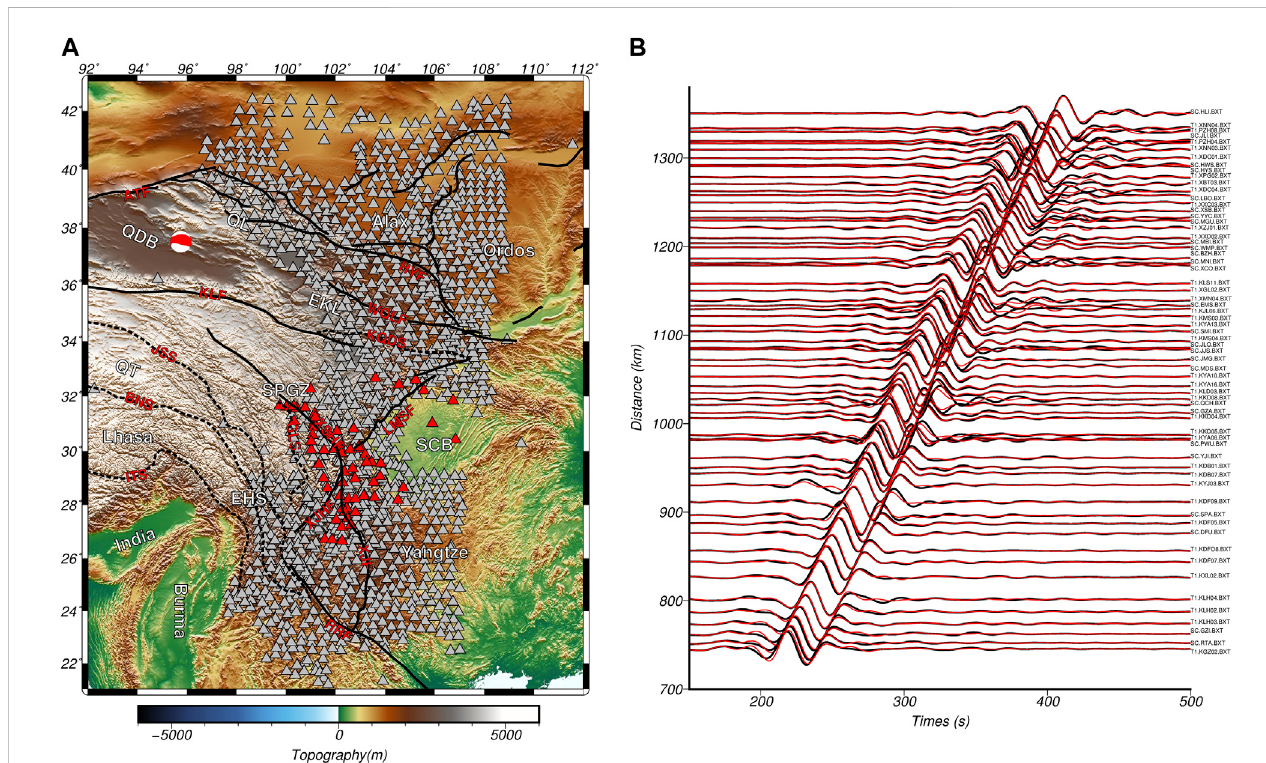
FIGURE 1 Topography, major tectonics, and seismic observations of theeasternTibetan Plateau. (A) Black solid and dashed lines represent faults and suture zones obtained fromtheHimaTibetMap-1.1dataset(Styronetal.,2010),respectively.GraytrianglesrepresentthedenseseismicarrayintheeasternTibetanPlateau. Red triangles and beach balls represent seismic stations and earthquake event shown for waveform fi tting. (B) Waveform fi tting of the selected stations and event(earthquakeID200811100122A,providedbyhttps://www.globalcmt.org).Blacklinesdenotethetransversecomponentoftheobservedwaveform and red lines denote the synthetics. ATF: Altyn Tagh fault, BNS: Bangong-Nujiang suture, EHS: Eastern Himalaya Syntaxis, EKL: eastern Kunlun terrane, GLS: Ganzi-Litang suture,HYF:Haiyuanfault,ITS:Indus-Tsangposuture,JSS:Jinshasuture,KQDS:Kunlun-Qinglin-Dabie suture,LMSF: Longmenshan